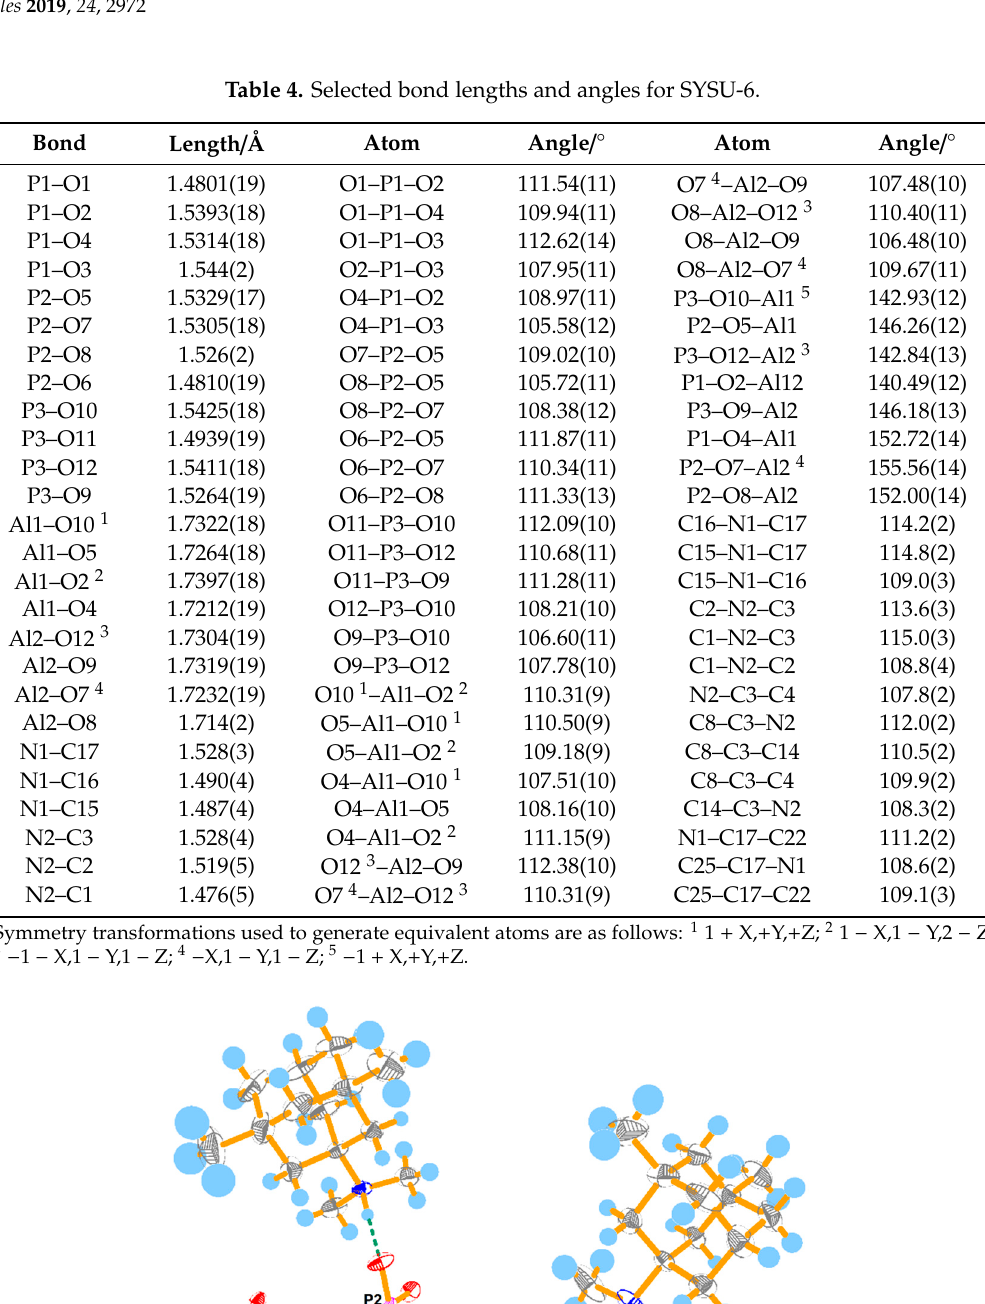
Table 4. Selected bond lengths and angles for SYSU-6. Bond